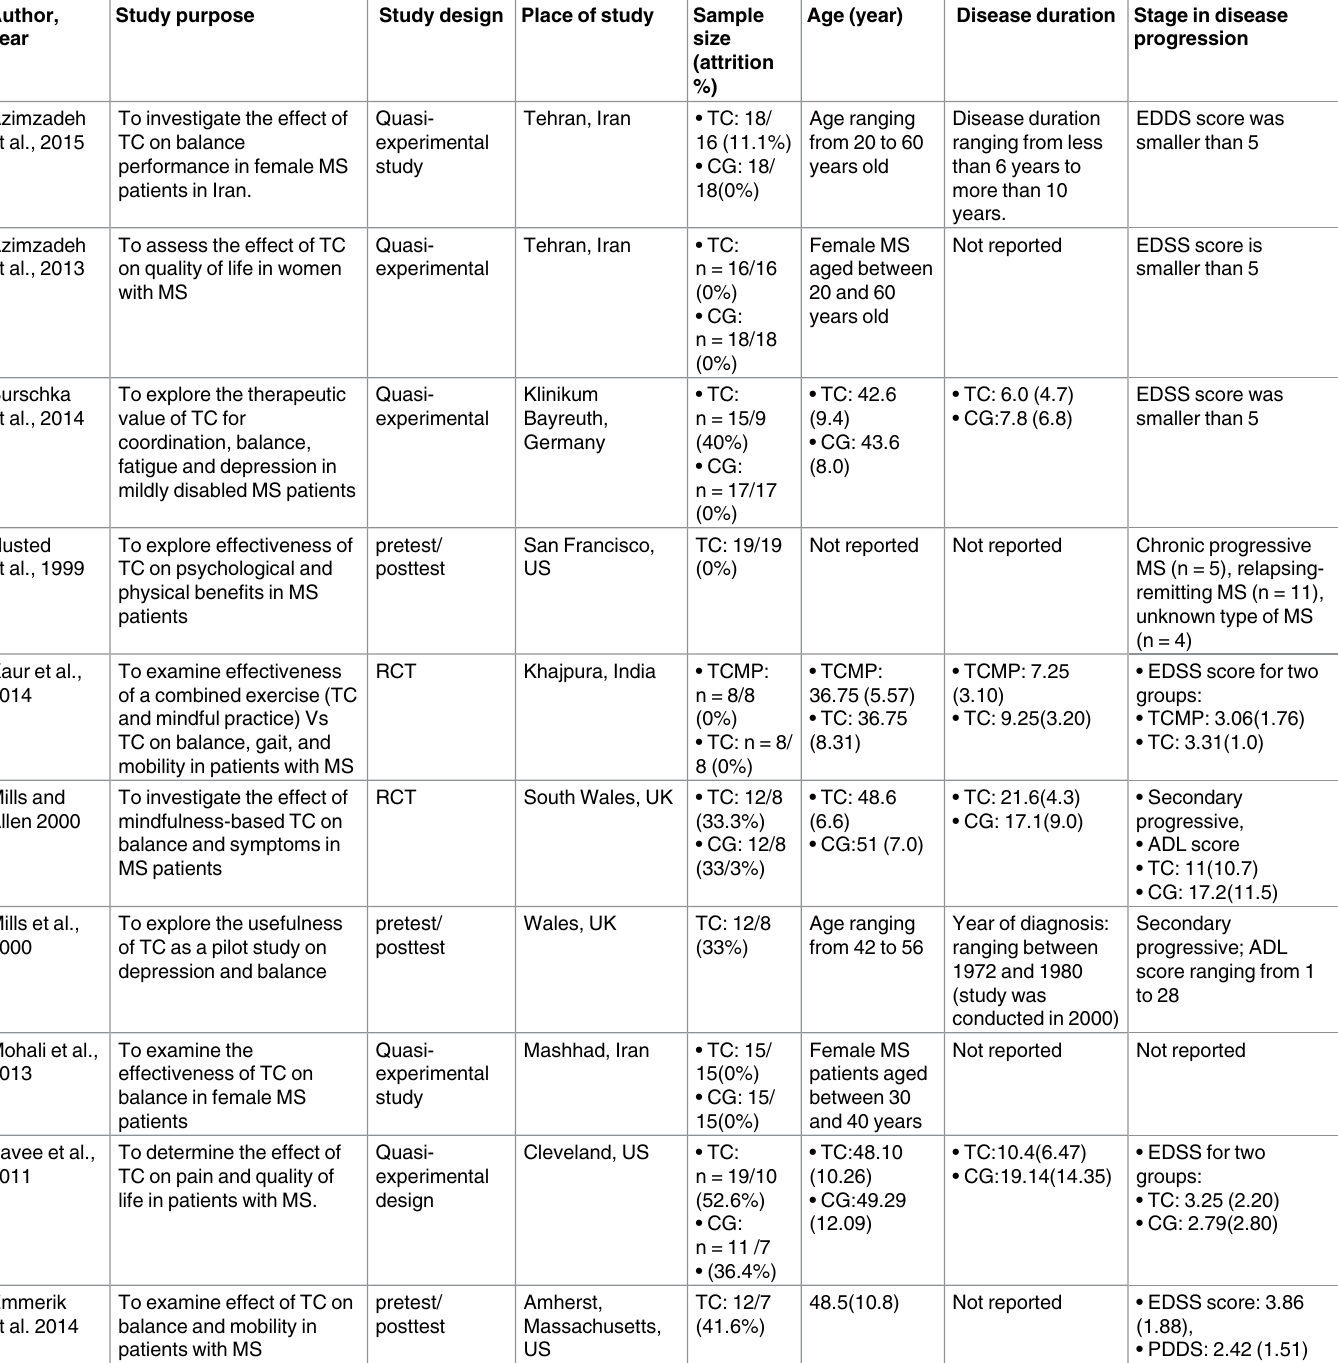
Table 3. Summaryof TC for patients with multiple sclerosis (study purpose, study design, place of study, sample size (attribution%), age of patients, disease duration, and stage in disease